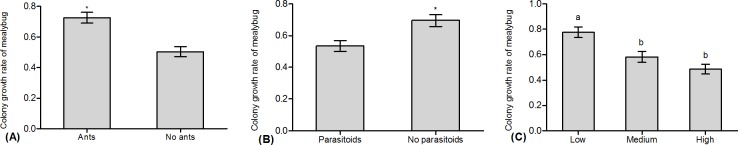
Effect of ant tending, the presence of parasitoids, and initial mealybug density on mealybug colony growth.(A): Ant tending; (B): Parasitoid; (C): Initial mealybug density.